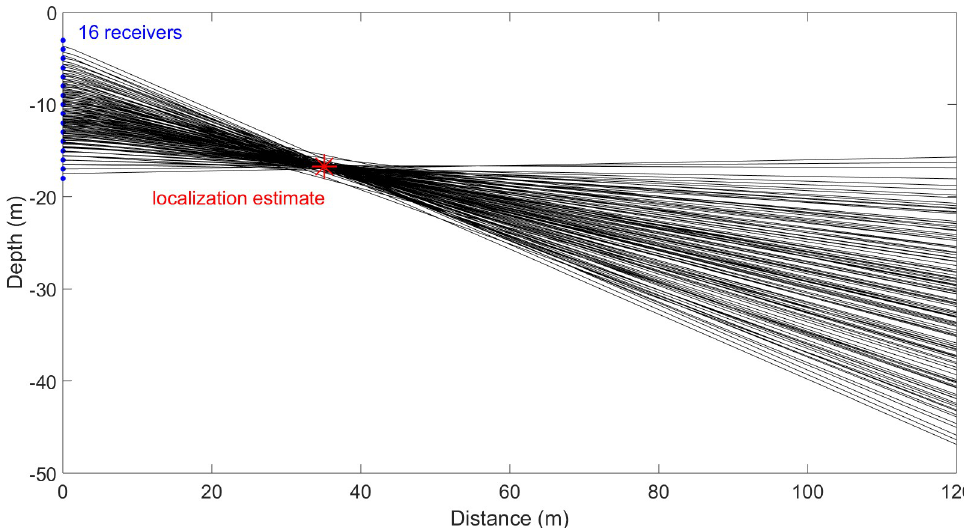
Fig 3. Hyperbolae for each of the 120 hydrophone pairs for a single click. Each blue dot on the y-axis indicates a hydrophone in the vertical array spaced 1 m apart. The red star demarcates the localization estimate in depth and distance from the array based on the least squares model. The hyperbolae intersect at the location of the analytical solution. https://doi.org/10.1371/journal.pone.0257054.g003 Beluga vertical beam width and sonar parameters Mean beluga sonar parameter values were similar between on-axis clicks in the vertical and horizontal planes and clicks on-axis only in the vertical plane (Table 1). A total of 133 clicks were on-axis in the vertical plane where both the ventral and dorsal -3 dB beam width could be